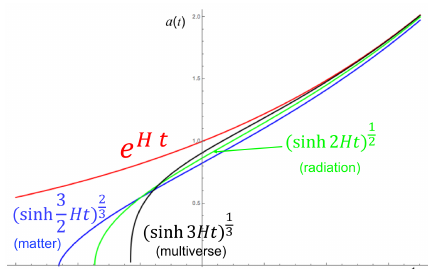
Figure 3. The departure of different pre-inflationary stages from the exponential DeSitter evolution of the universe (red): matter-dominated evolution (blue), radiation-dominated evolution (green), and the evolution dominated by the quantum corrections induced by the interactions between universes (black). Ref. [9]